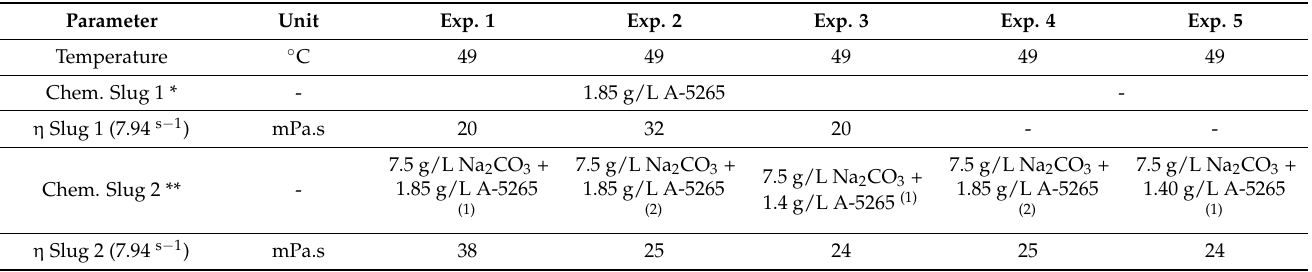
Table 4. Summary of parameters in Berea outcrop flood experiments performed in this work. Core orientation was vertical, pore pressure was 5 bar, injection rate was 1 ft/day, and radial pressure was 30 bar in all cases.